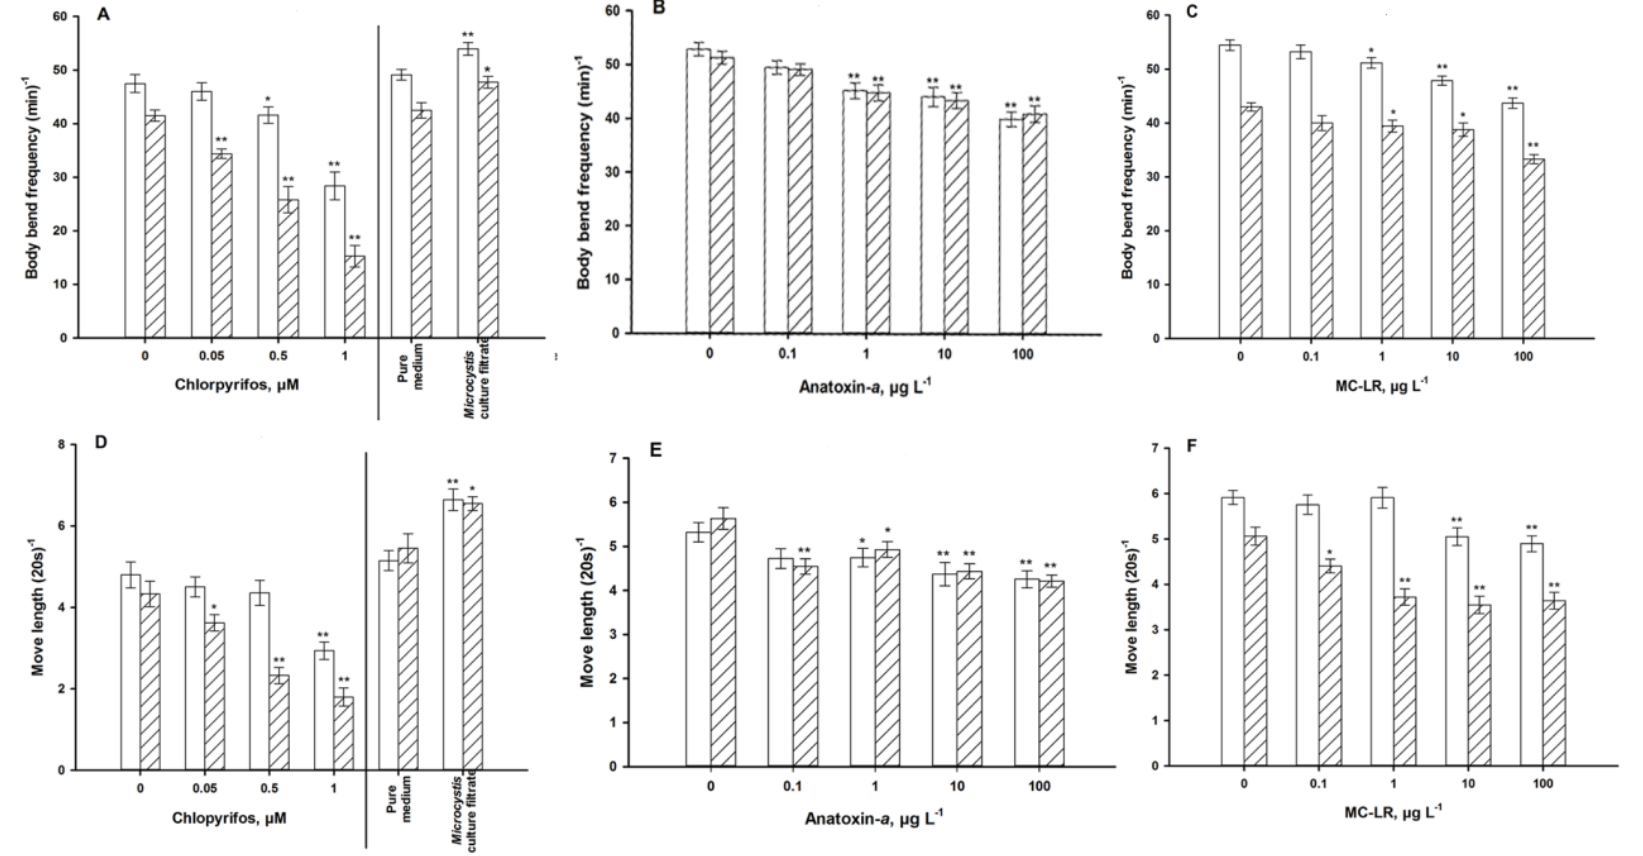
Figure 4. Locomotive behavior of young adult nematodes for 24 h ( white ) and 72 h ( hatched ). Move length is normalized by the mean of body length per group. ( A,D ): exposure to chlorpyrifos and a Microcystis culture filtrate. ( B,E ): exposure to anatoxin- a . ( C,F ): exposure to microcystin-LR. * = p < 0.05, ** = p <